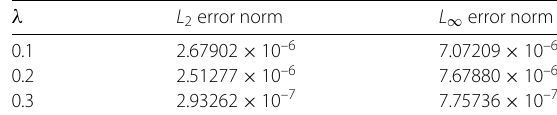
Table 2 L 2 and L ∞ error norm when β =